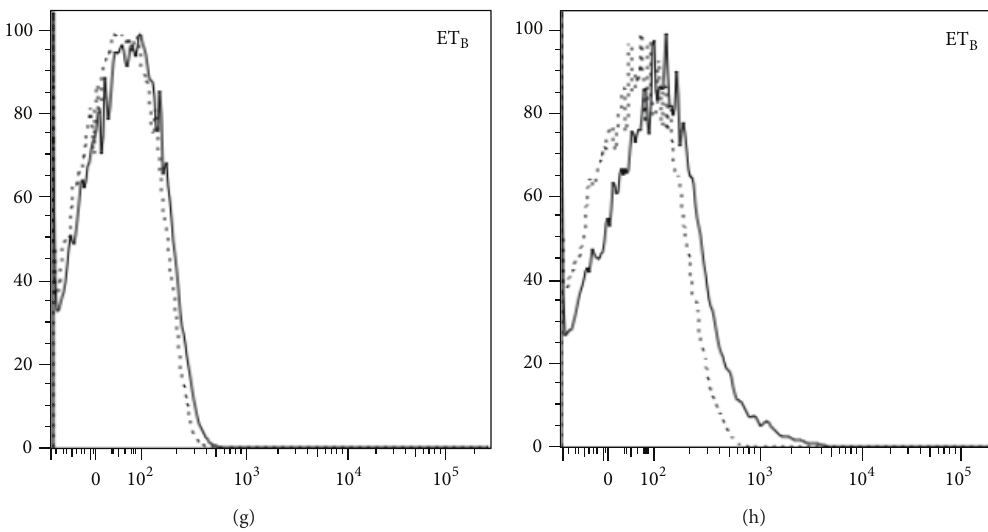
Figure 3: Change in ET A and ET B expression on activated T CD4+ and CD8+ cells. The stimulation of cells, performed with microbeads coated by anti-CD3/CD28 antibodies, leads to a reduction of ET A and an increase of ET B expression, both in CD4+ (a-b; c-d) and CD8+ cells (e-f; g-h), respectively. The profile of one of ten similar experiments is shown.